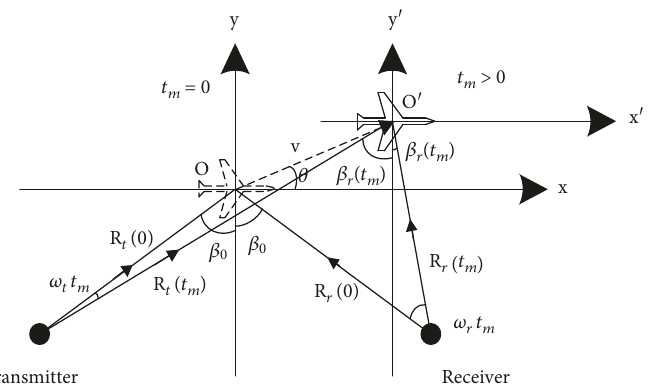
Figure 1: Bistatic inverse synthetic aperture radar (B-ISAR) imaging